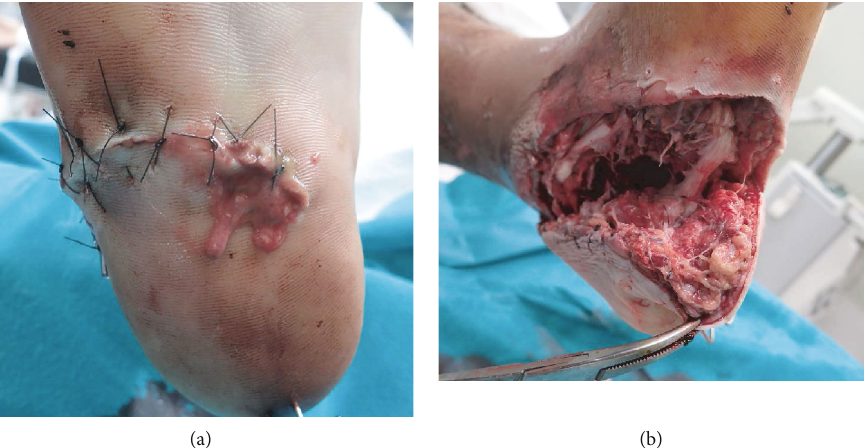
Figure 4: Two days after the injury. (a) Obvious signs of wound infection including pus, spreading redness, and increased swelling. (b) Irrigation and debridement were performed, and the wound was left